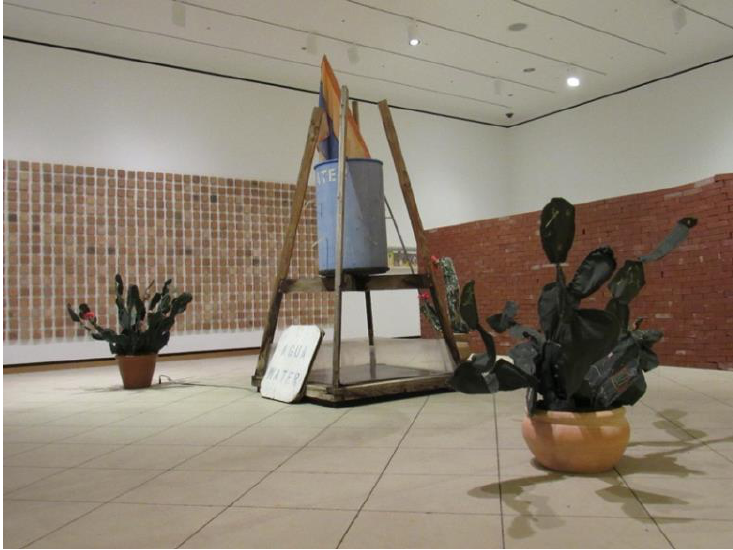
Figure 8 ,Guillermo Galindo, Fountain of Tears/Fuente de Lágrimas (2014). Wood, iron plate, barrel, pump, plastic tubes, water, and beacon flag (center); Margarita Cabrera, Space in Between – Nopal # 2 (2012) (left), Space in Between – Saguaro (Maria Lopez) (2010) (back), and Nopal con Tunas # 2 (2006) (front). Fabric, copper, wire, and terra cotta pots; Teresa Margolles, La Gran América (2017). Fired clay (back left); Jorge Méndez Blake, Amerika (2019). Bricks and edition of Amerika by Kafka (back right). Installation view of how the light gets in at Herbert F. Johnson Museum of Art, Cornell University